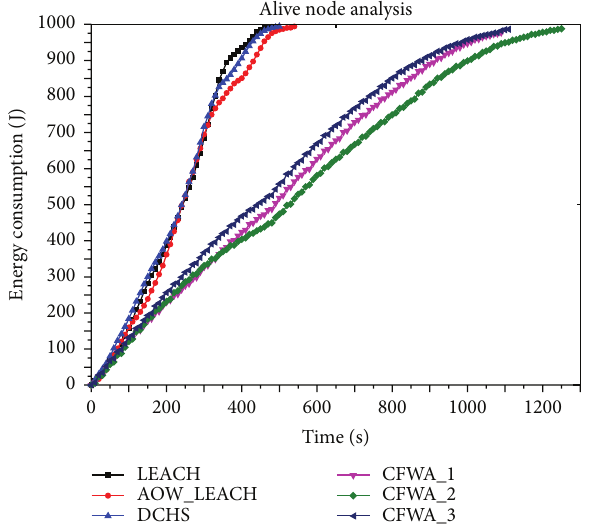
Figure 10: Traffic comparison diagram between CFWA family algorithms and LEACH-like algorithms in 200 nodes.